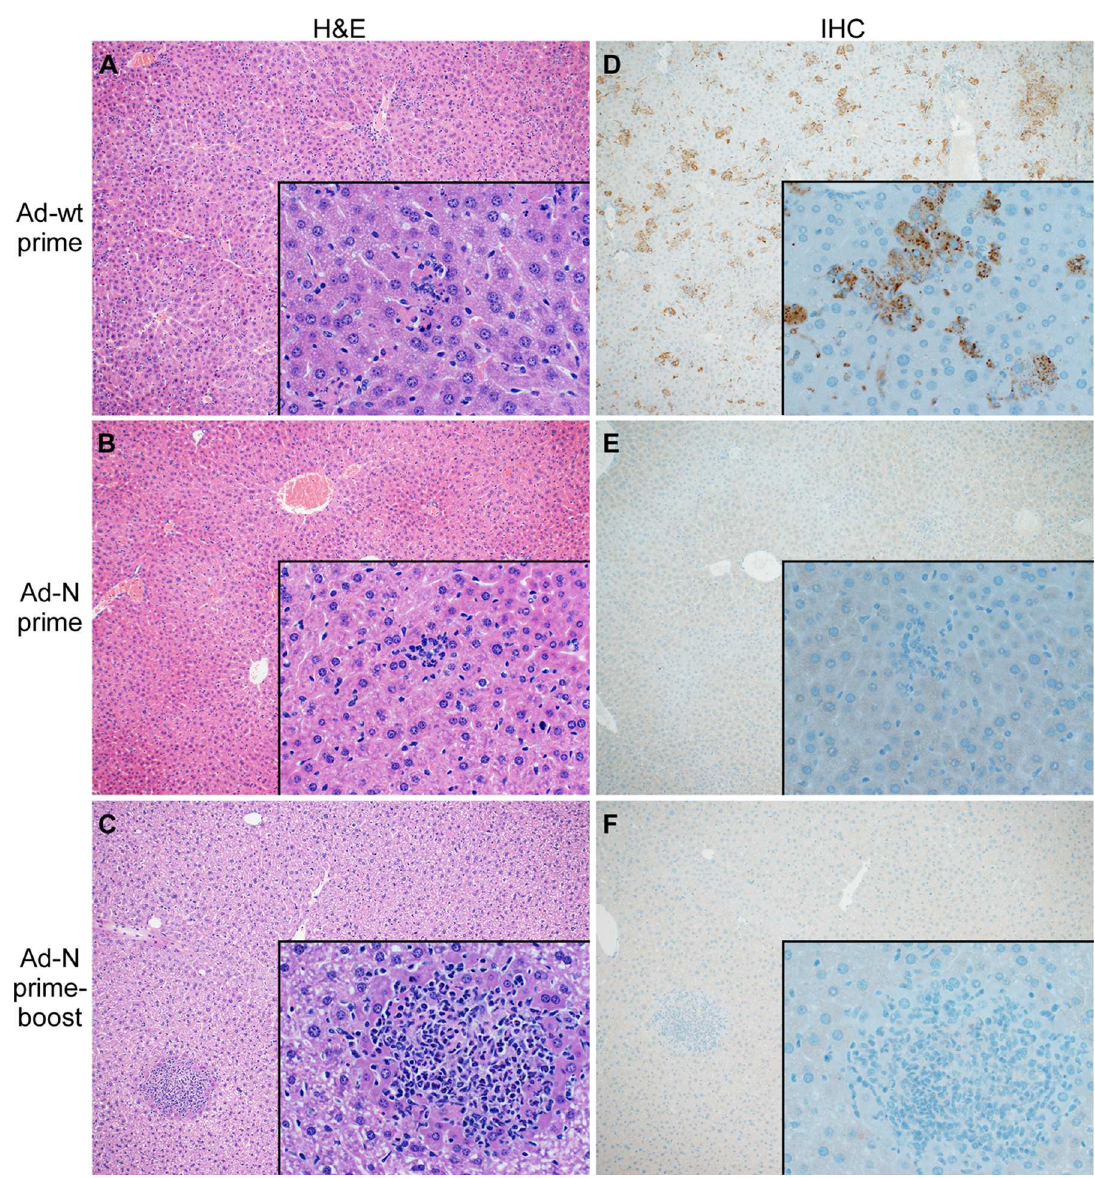
Fig 3. Liver histopathology and CCHFV antigen distribution in single-dose and prime-boost vaccinated and challenged mice. Groups of IFNAR -/- mice were either single, (1.25×10 7 IFU; intramuscular) or prime-boost (1.25×10 7 IFU; intramuscular / 10 8 IFU; intranasal) vaccinated with Ad-N or Ad-wt and challenged with 1000 LD 50 of CCHFV 28 days following final vaccination. Mice (n = 9 per group) were anesthetized, bleed and euthanized to harvest organ samples on day 3 post CCHFV challenge. Thin-sections of liver material were stained with hematoxylin and eosin (H&E) or with N 1028 rabbit polyclonal serum (anti-CCHFV N serum) (IHC). (A) Liver H&E of control-vaccinated mice (Ad-wt), (B) Liver H&E of prime-vaccinated mice (Ad-N); (C) Liver H&E of prime-boost- vaccinated mice (Ad-N); (D) Liver IHC of control-vaccinated mice (Ad-wt); (E) Liver IHC of prime-vaccinated mice (Ad-N); (F) Liver IHC of prime-boost-vaccinated mice (Ad-N). Images are at a magnification of 10x with 500x